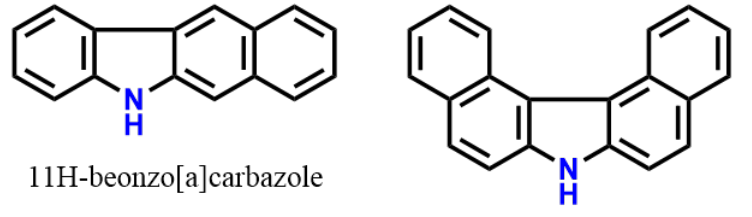
Figure 12. Molecular structures for pyrrolics containing 11H-benzo[a]carbazole and 7H-dibenzo[c,g] carbazole. These molecules belong mostly to the Aro-3 fraction and partially to the Resins fraction. (The blue color indicates the NH group.)